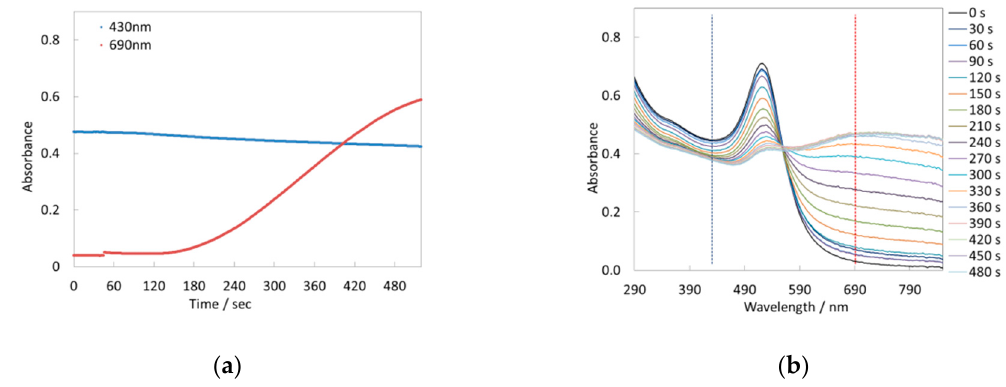
Figure 4. Aggregation kinetics of an AuNP solution, run-time = 8.5 min. Addition of an aggregation promoter generates different levels of color change, which leads to changes in the LED signals. ( a ) 2-LED-µSpectrophotometer absorbance values at the selected wavelengths after salt addition at t = 40 s; ( b ) corresponding UV/vis curve using benchtop spectrometer in an overall time of 8 min.